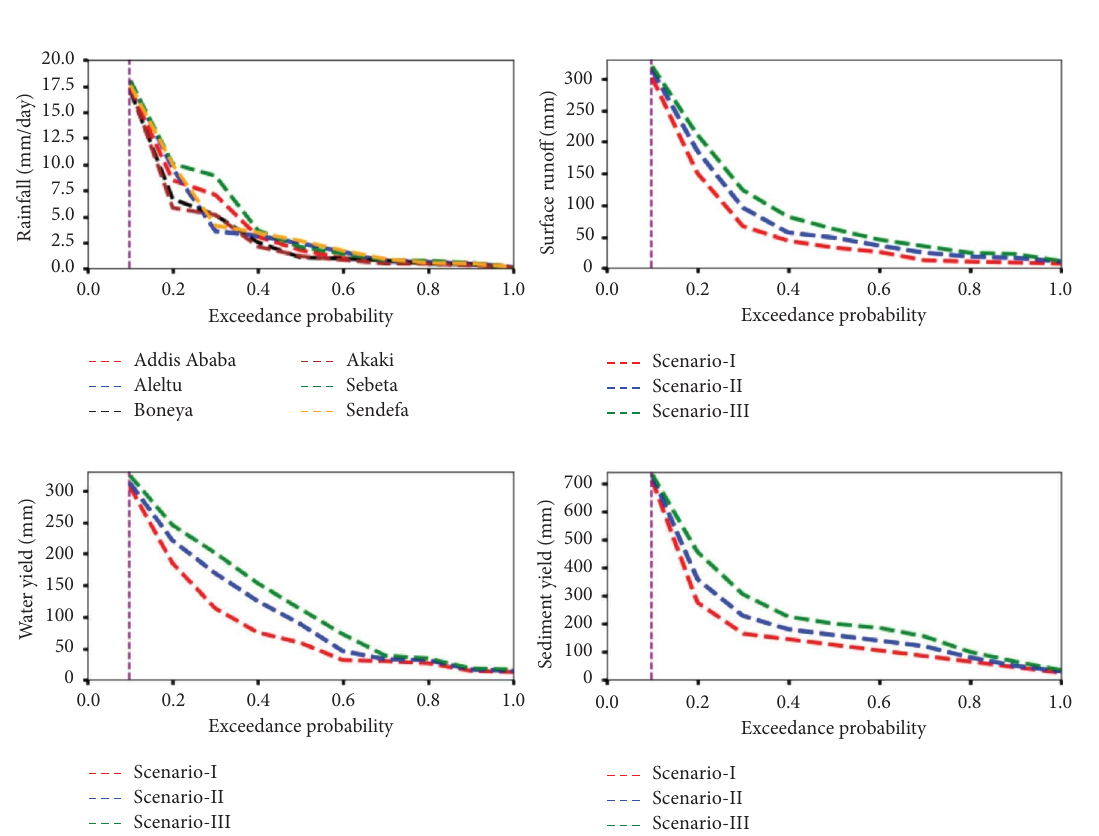
Figure 9: Annual exceedance probability of runof and sediment yields under LULC